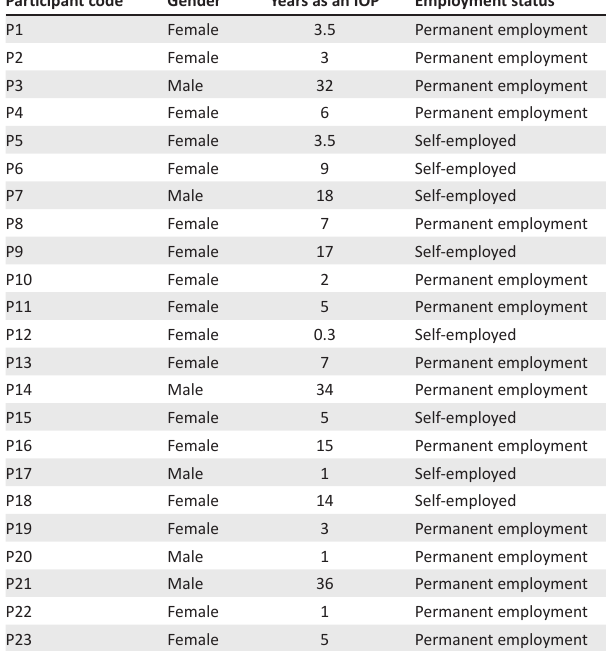
TABLE 1: Participants’